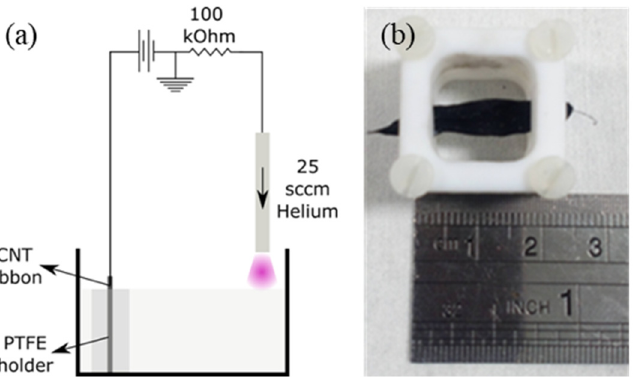
Figure 1. ( a ) The configuration of the plasma-induced non-equilibrium electrochemistry system used to treat the ribbons, and ( b ) a photograph illustrating the PTFE holder used to secure the carbon nanotubes.